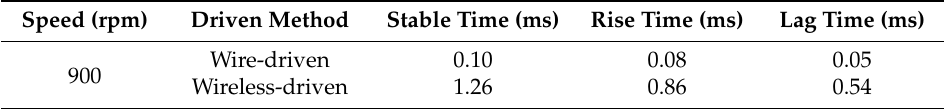
Table 8. Time response comparisons of the wire- and wireless-driven, single-phase switched reluctance